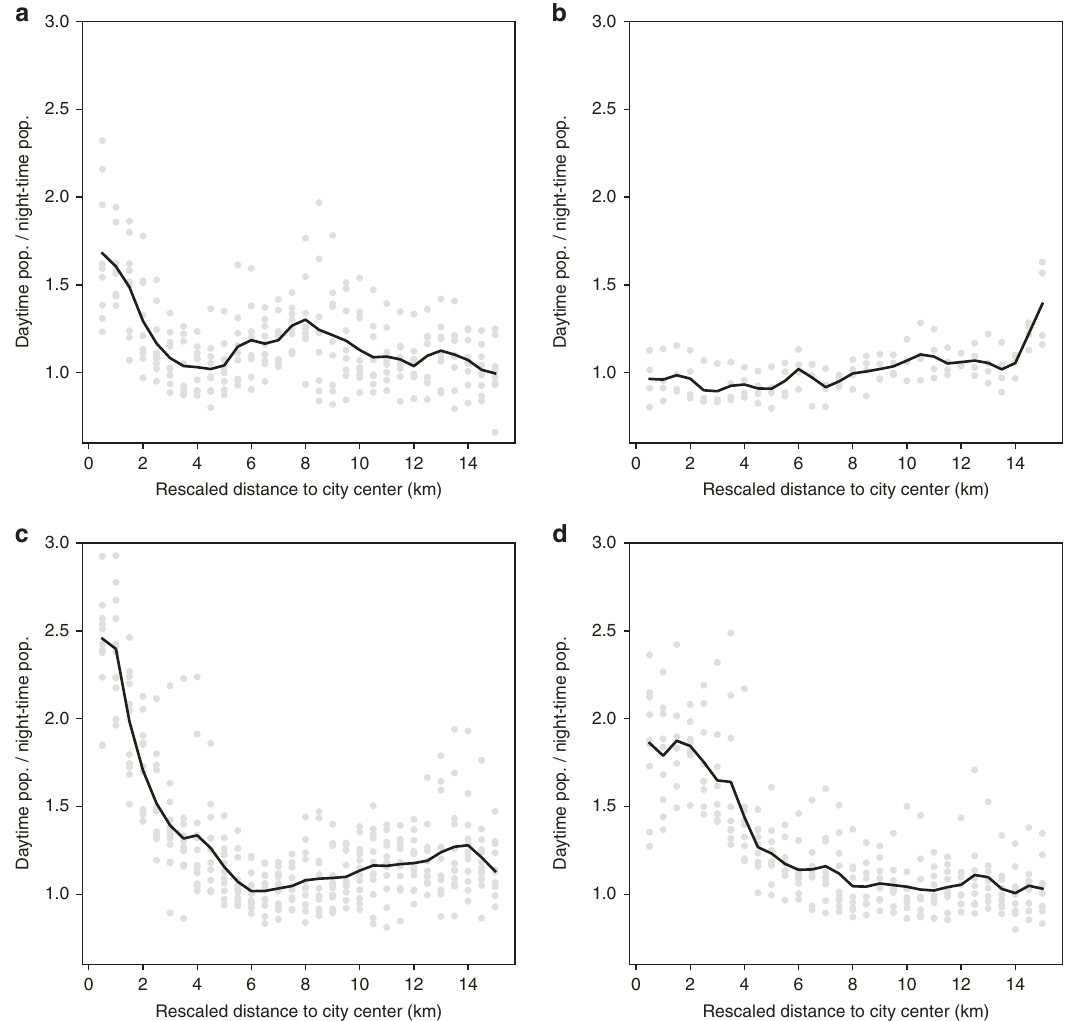
Fig. 4 Cluster analysis of EU cities. Ratio between day- and nighttime population densities for the 34 EU cities with a population above 1 million in 2011, grouped in 4 clusters determined using the k -means method. Each panel ( a – d ) corresponds to a subset of the 34 cities with a similar spatio-temporal population pro fi le. Source data are provided as a Source Data spreadsheet fi le.